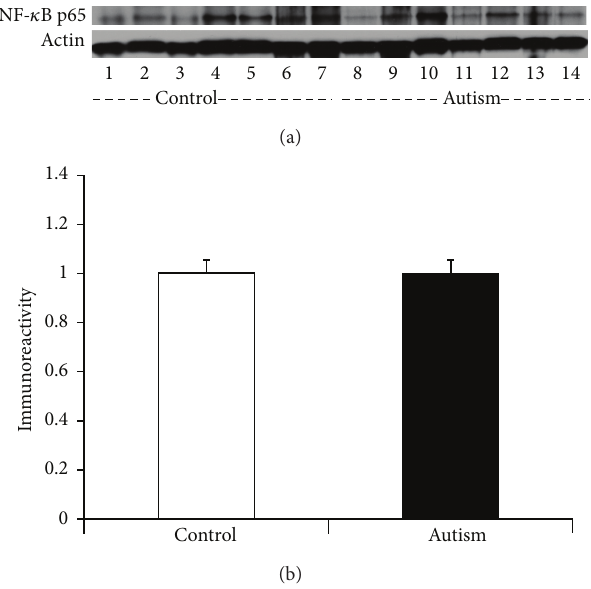
Figure3:NF- 𝜅 Bp65proteinexpressioninthecerebellumofautistic subjects. Western blot studies on cerebellar homogenates using I 𝜅 B 𝛼 antibody (dilution 1: 500). Lanes 1–7 represent control subjects and lanes 8–14 represent autistic subjects. The western blot results were quantitated after being normalized by actin. Data are shown as mean ±